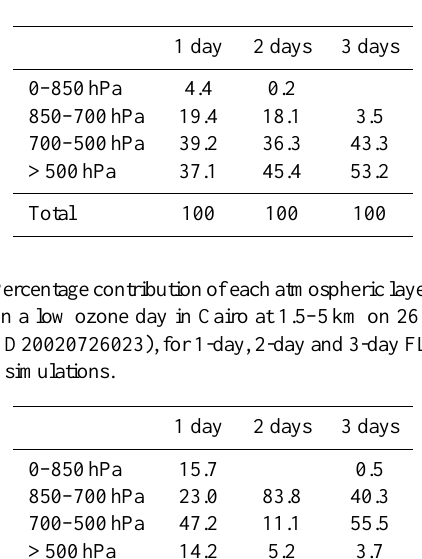
Table 1. Percentage contribution of each atmospheric layer to the air arriving on a high ozone day in Cairo at 1.5–5km on 30 July 2003 (Flight: MA20030730103), for 1-day, 2-day and 3-day FLEXPART backward simulations.